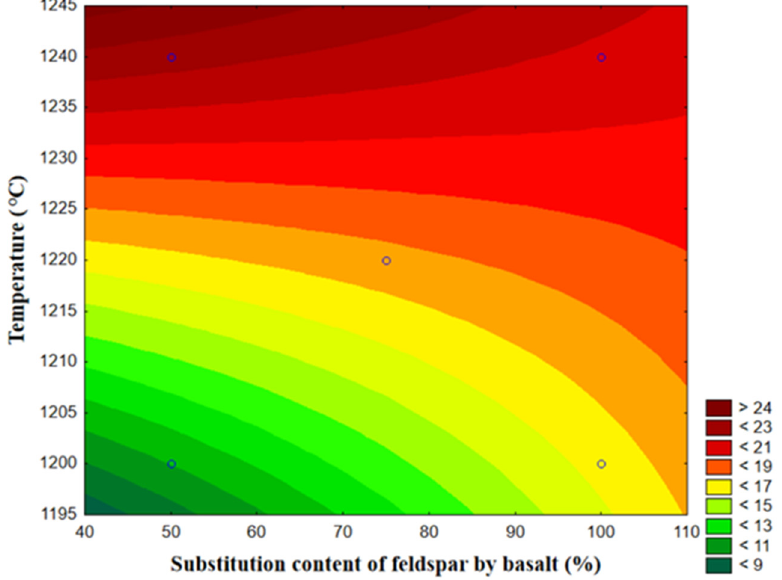
Figure 11. Response surface of the samples related to the flexure strength of studied compositions.